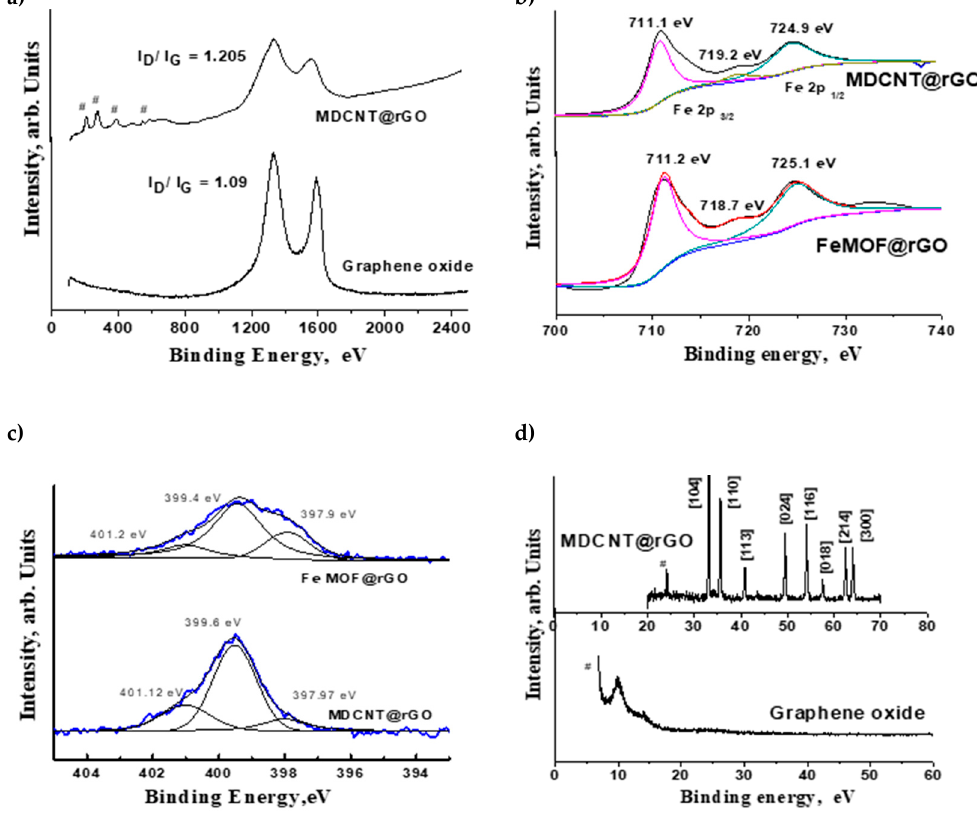
Figure 3. Raman spectra ( a ); Deconvoluted Fe2p ( b ); Deconvoluted N1 s XPS spectra ( c ) and X-ray diffraction (XRD) of MDCNT@rGO ( d ).